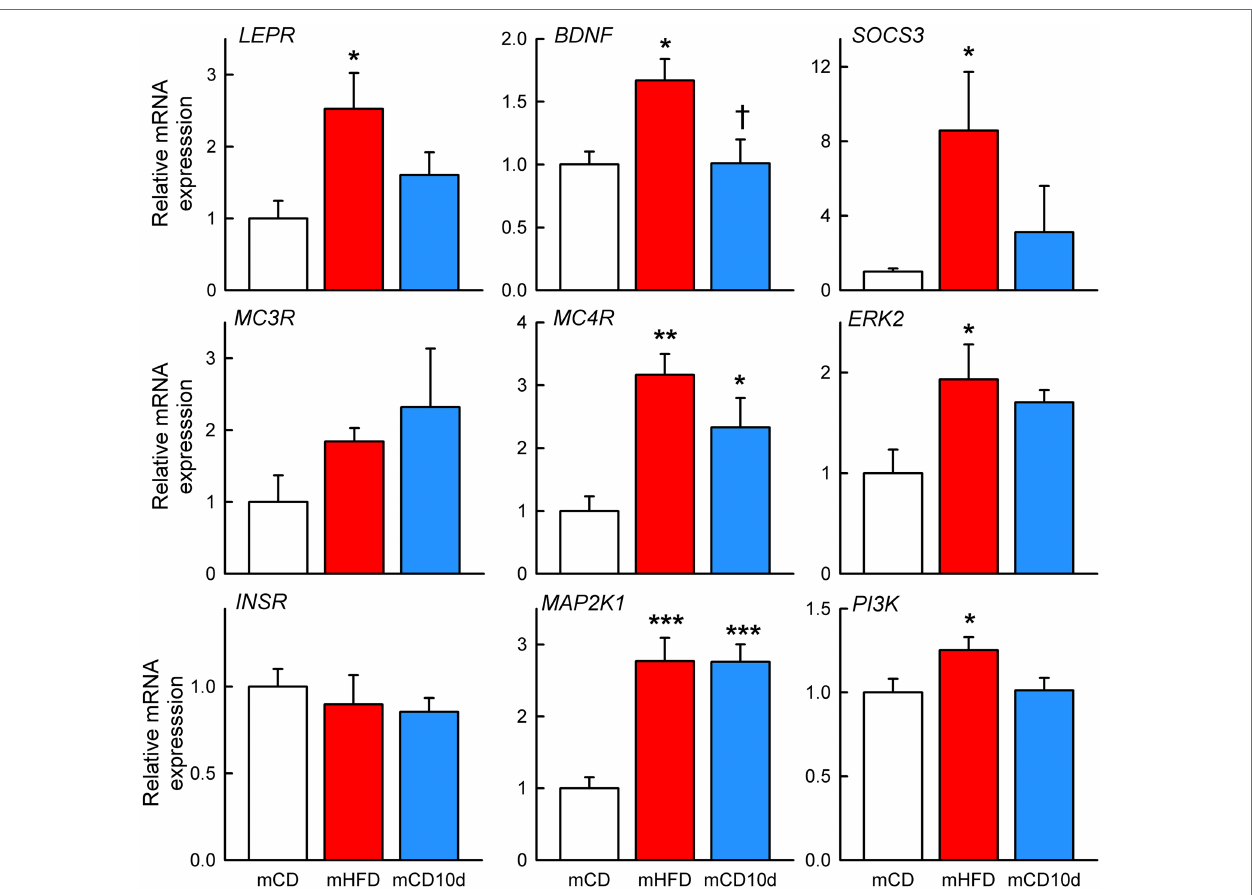
FIGURE 13 | Hypothalamic mRNA expression in offspring. Relative expression of mRNA in mHFD (red bars, n = 4–5) and mCD10d (blue bars, n = 5–6) rabbits compared to mCD (white bars, n = 4–5). Relative expression of LEPR , BDNF , suppressor of cytokine signaling 3, melanocortin 3 and 4 receptors,